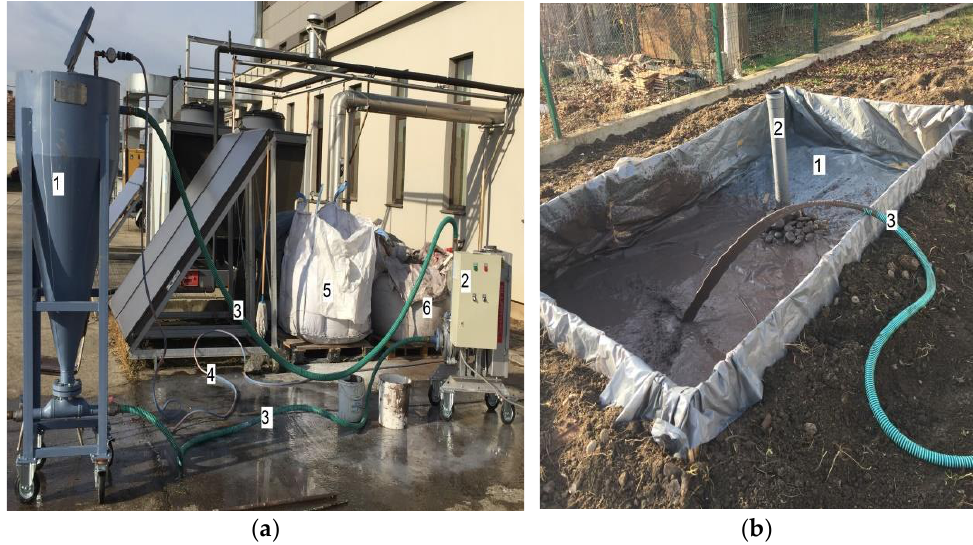
Figure 1. Landfill disposal material construction: ( a ) hydraulic mixing device: 1 — tank, 2 — centrifugal pump, 3 — recirculation hose, 4 — water feeding hose, 5 — APC residues, 6 — FA and FGD residues; ( b ) landfill mold: 1 — plastic membrane, 2 — drain system, 3 — slurry discharge hose.